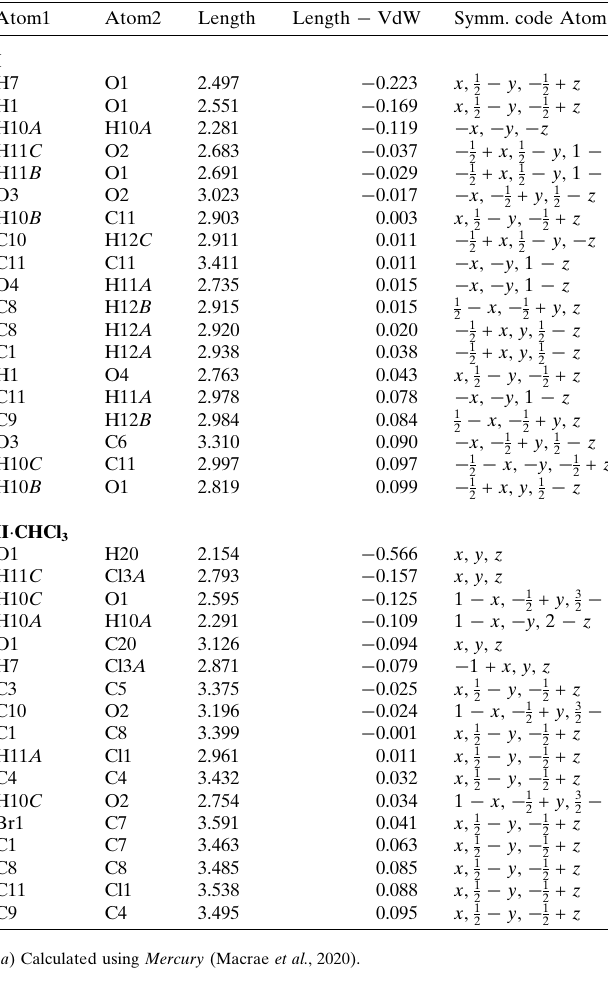
is given in Table 3. The Hirshfeld surfaces of I and II II (cid:2) CHCl 3